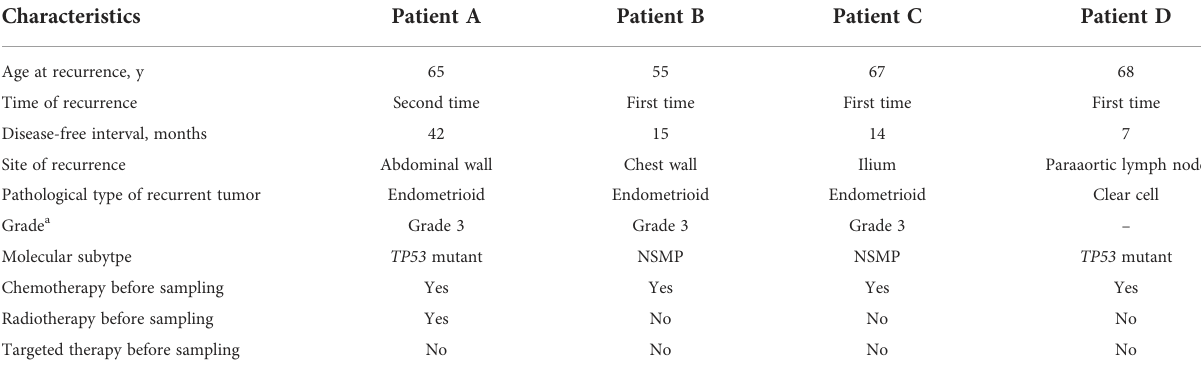
TABLE 2 Clinicopathological and molecular features of recurrent EC cases.